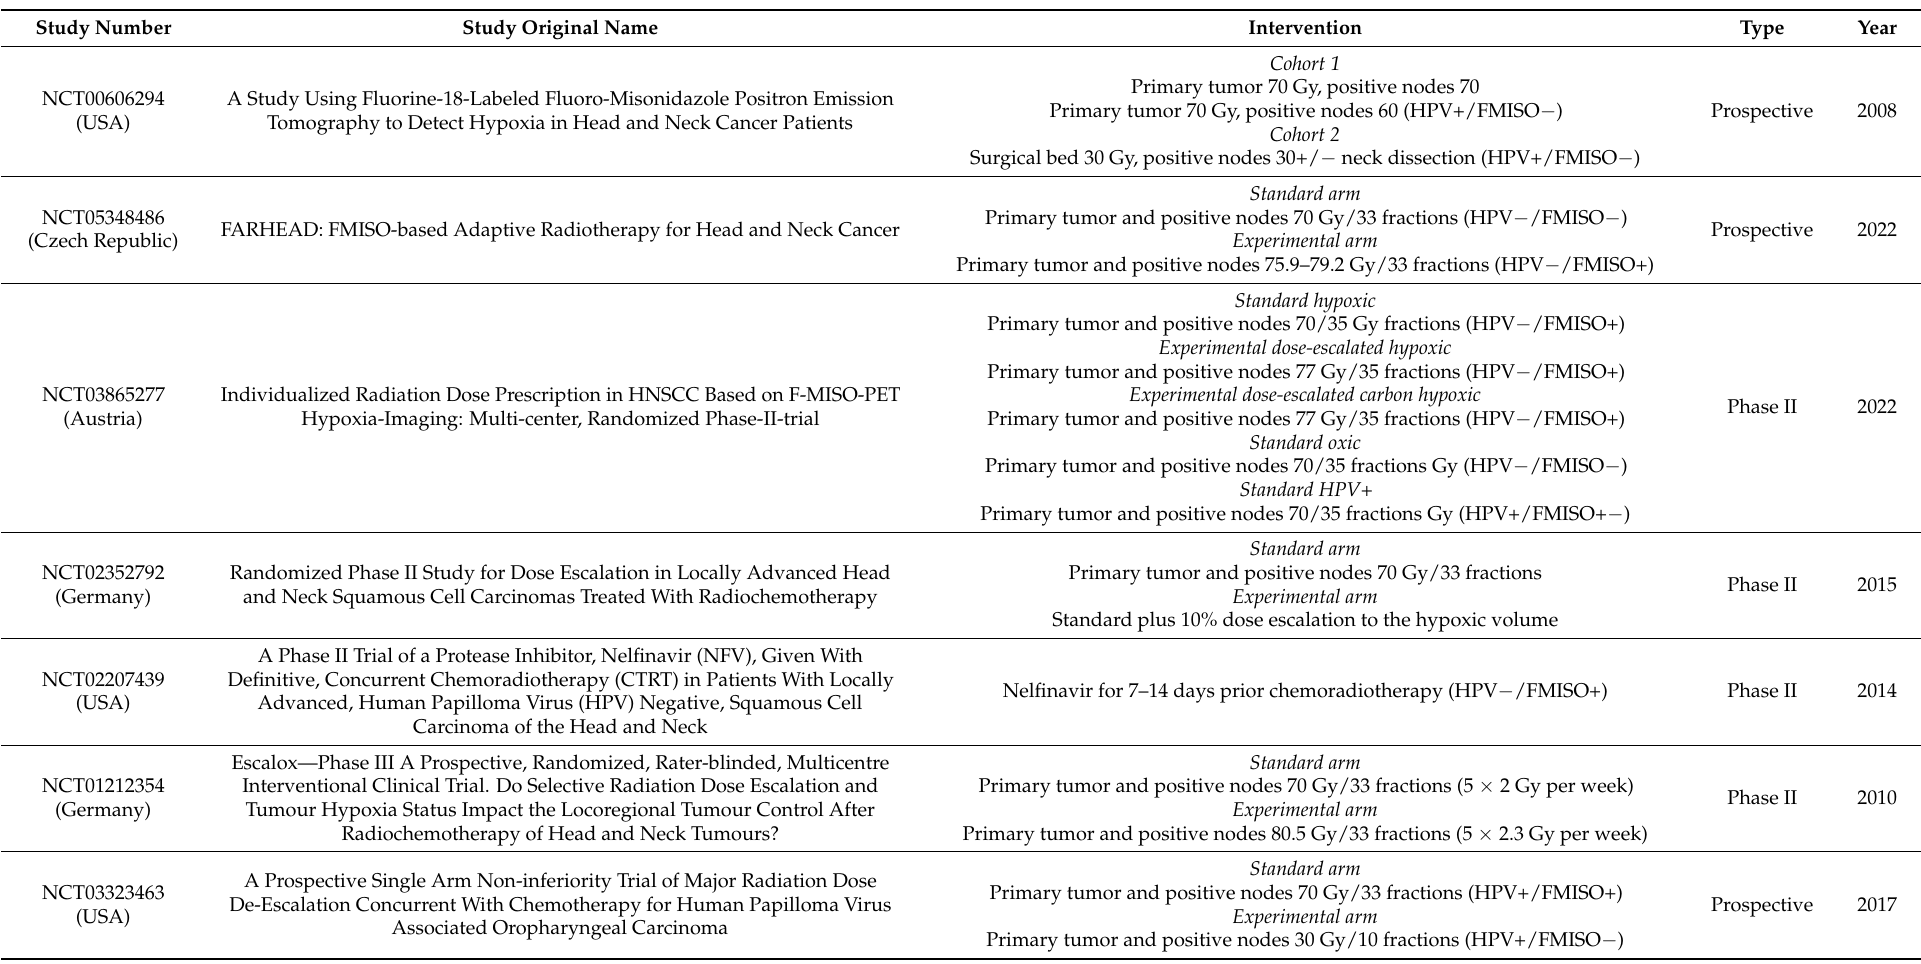
Table 1. Ongoing studies using FMISO in the adaptation of the irradiation